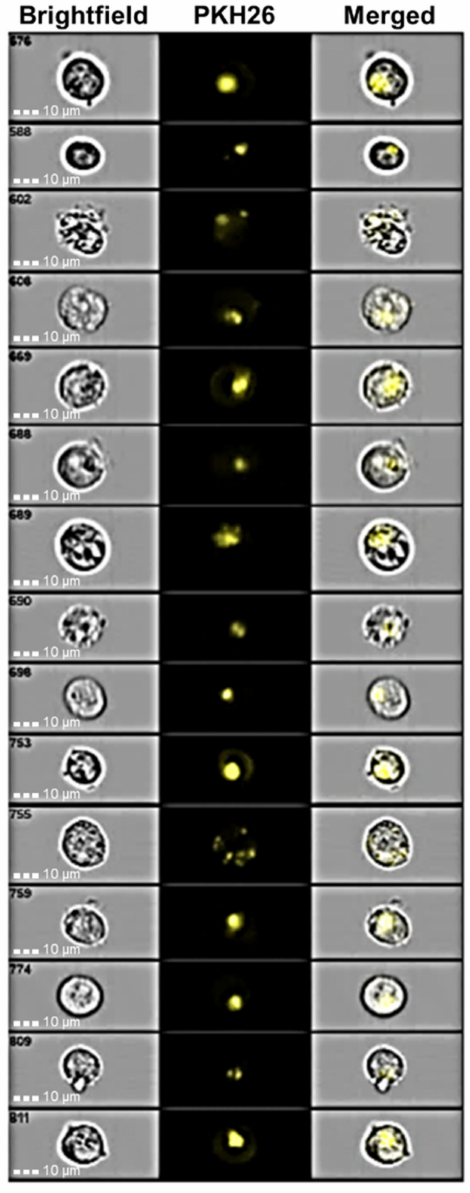
Figure 10. Image cytometry of K-562 treated for 6 h with labeled NPs. To evaluate the localization of the internalized NPs, experiments were performed using K-562 cells previously intracytoplasmic labeled with Alexa fluor 647-conjugated anti-human CD107a (LAMP-1) antibody. CD107a is a glycoprotein expressed on lysosome membranes, and its linkage with the fluorescent antibody permits identification of lysosomes within the cells. Labeled cells were co-incubated with labeled NPs for 6 h, and the obtained images are shown in Figure